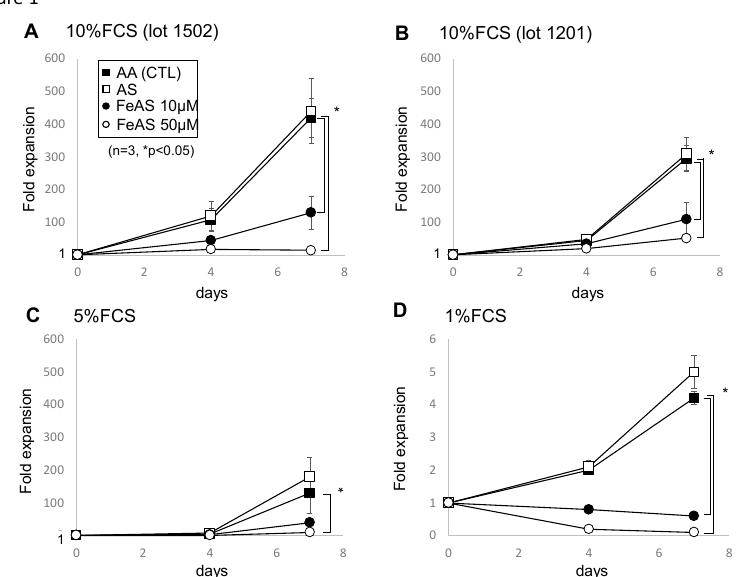
Figure 1. Ferrous ammonium sulfate (FeAS) interfered with the growth of LSKs in the liquid culture system. Lineage − Sca1 + c-Kit + (LSK) cells isolated from murine bone marrow (BM) were cultured in α MEM medium containing hematopoietic cytokines (100 ng/mL each) and supplemented with 10% FBS ( A , B ), 5% fetal bovine serum (FBS) ( C ), or 1% FBS ( D ) in the absence (untreated (AA CTL) or the presence of 10 µ M (FeAS 10 µ M) or 50 µ M (FeAS 50 µ M) ferrous ammonium sulfate, or with ammonium sulfate (AS). Total viable cell numbers were determined using an ATP assay. Data shown indicate the mean ± SD of summarized data obtained from three independent experiments (* p <